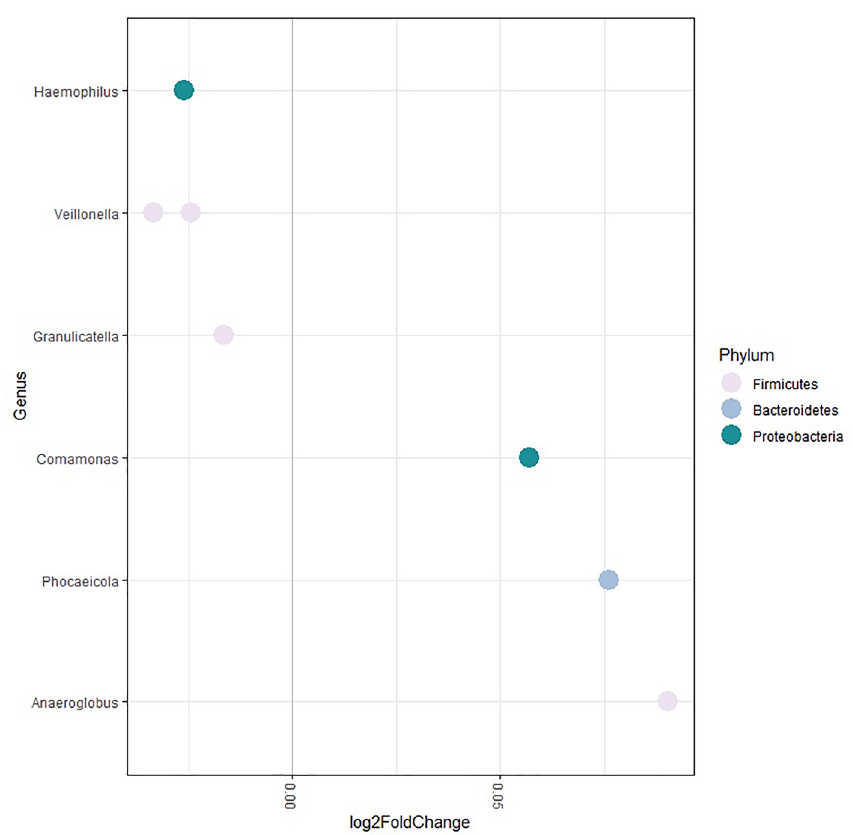
(Q = 0.029), Phocaeicola abscessus (Q = 0.037) and Anaeroglobulus germinatus (Q = 0.004). Taxa inversely associated with age were Veillonella (Q = 0.0002), Haemophilus (Q = 0.0004), Veillonella atypica/dispar (Q = 0.037) and Granulicatella adiacens/para-adiecens (Q =